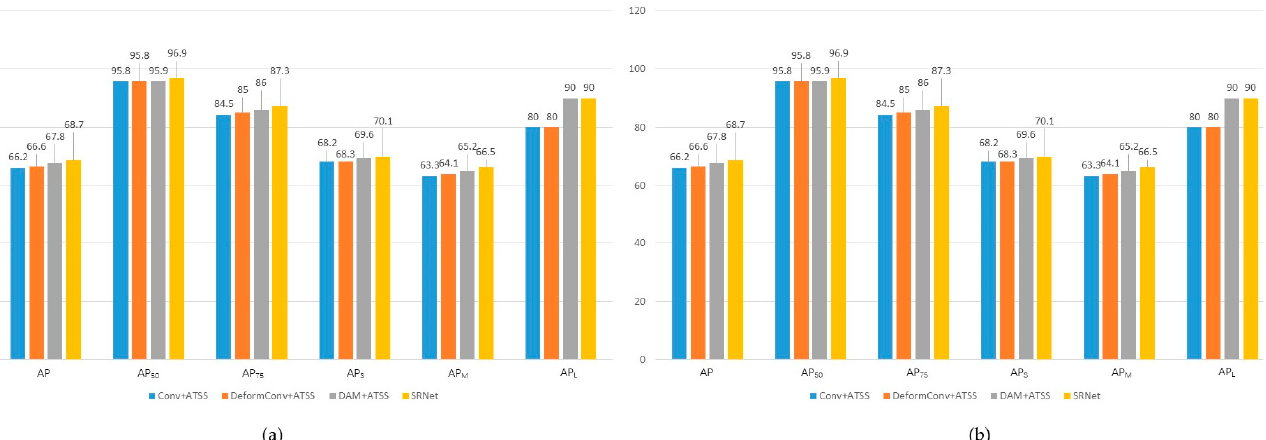
Table 5. Ablation experiment results of our network framework on the SSDD dataset. Table 6. Ablation experiment results of our network framework on the Instance-RSDD dataset.